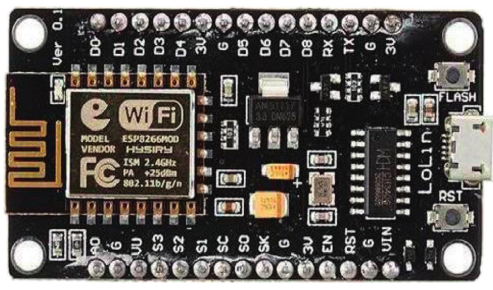
Figure 6: ESP8266